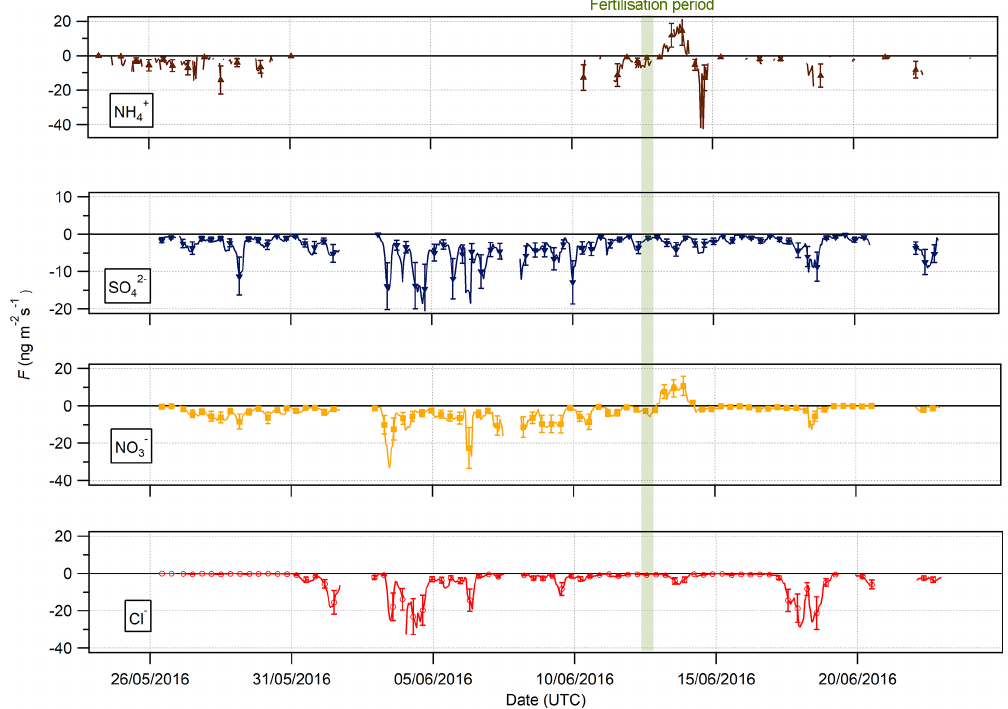
Figure 9. Time series of hourly fluxes of water-soluble aerosol species measured during the Easter Bush campaign. Results smoothed using a 5h moving point average. The fertilisation period was 10:00 on 13 June and is highlighted in green. Flux uncertainties for each aerosol are included as error bars.